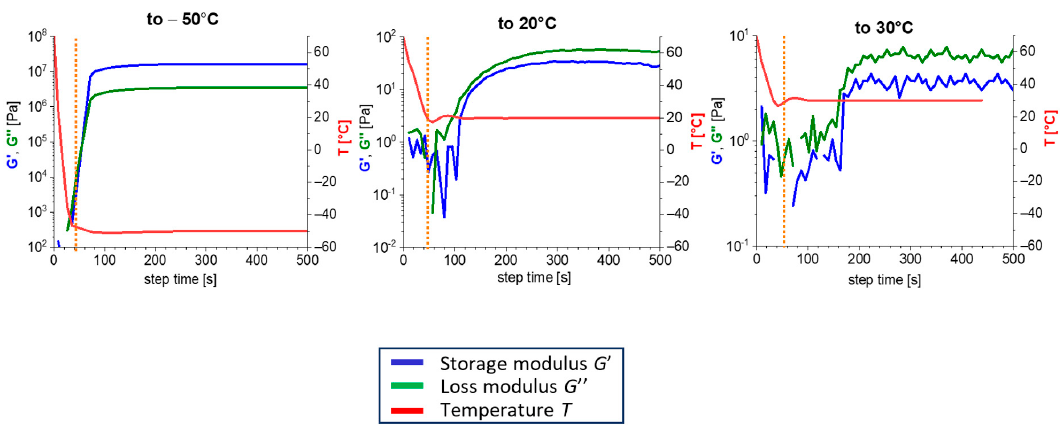
Figure 3. Exemplary kinetics of the change in storage ( G ’) and loss ( G ”) modulus (kinetics of physical gelation) upon quenching molten H11–BAFKU 2 from 70 °C down to − 50 °C (left), to +20 °C (center) and to +30 °C (right); the entire set of results for the different final temperatures tested is shown in Figure S3; at final temperatures above +45 °C, practically no change in moduli is observed upon quenching.